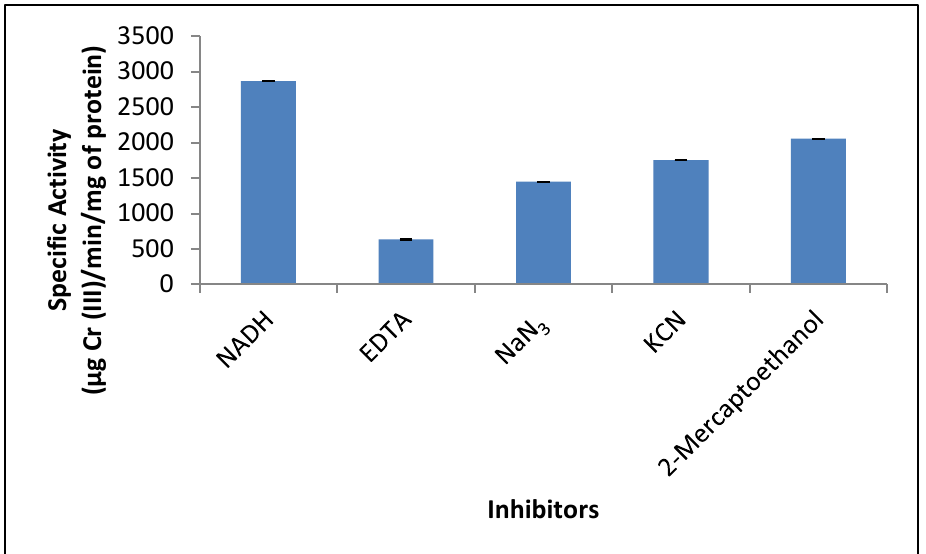
Figure 6. Effect of inhibitors on crude reductant activity in mixed membrane fraction of Purpureocil- lium lilacinum . 1 h of incubation, pH 7.0, 100 rpm, and 37 ◦